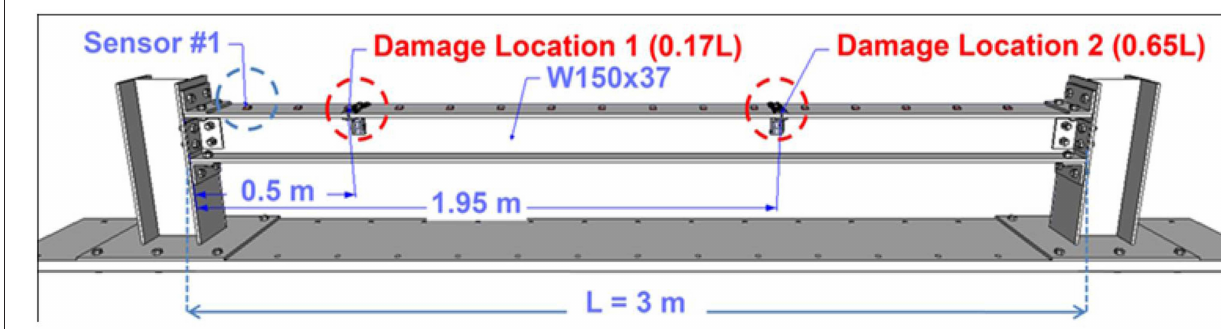
FIGURE 1 | Test beam configuration (Shahsavari et al., 2017).